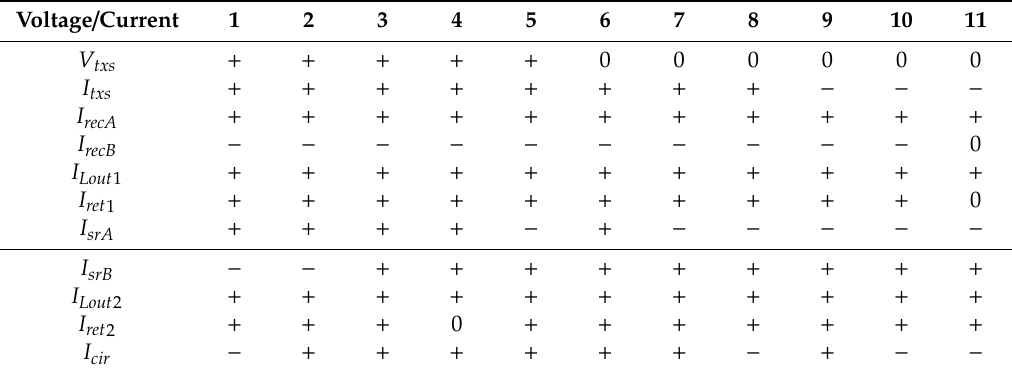
Table 4. Definition of operation modes.